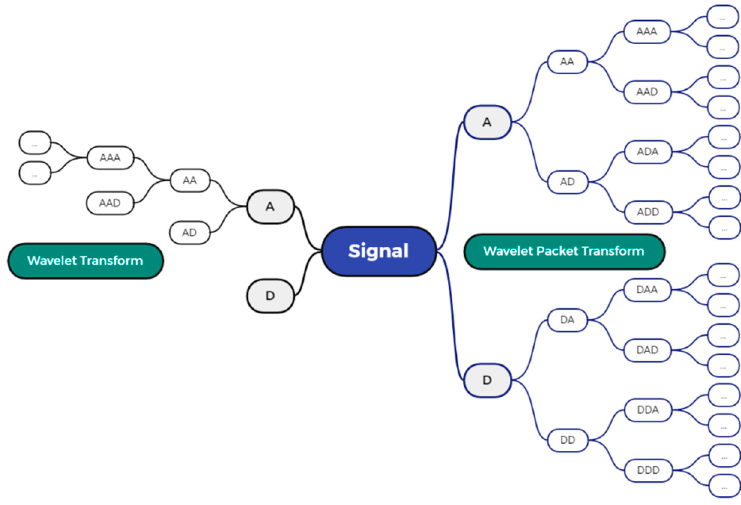
Figure 4. The difference between wavelet transform and wavelet packet transform. A means the wavelet coefficient of the low-frequency component in the signal. D means the wavelet coefficient of the high-frequency component in the signal.